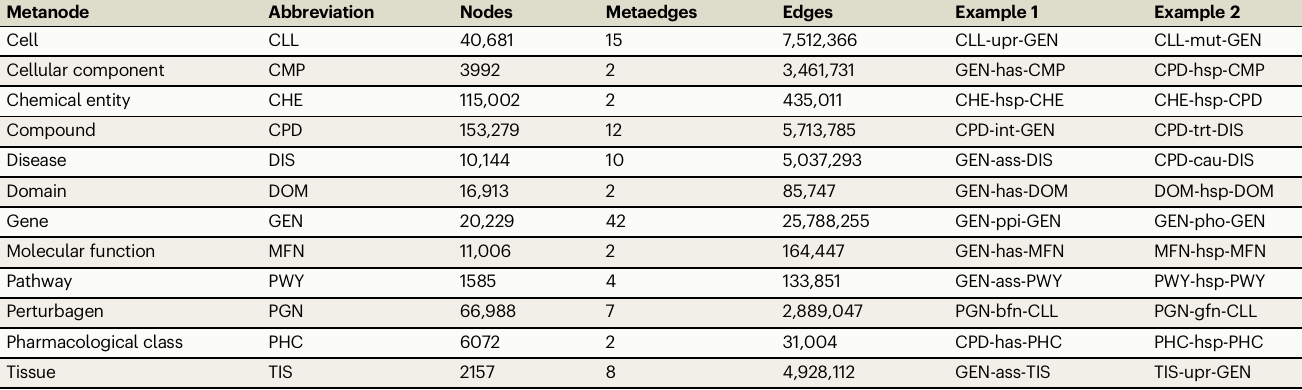
Table 1 | Biological and chemical entities in the knowledge graph (KG)